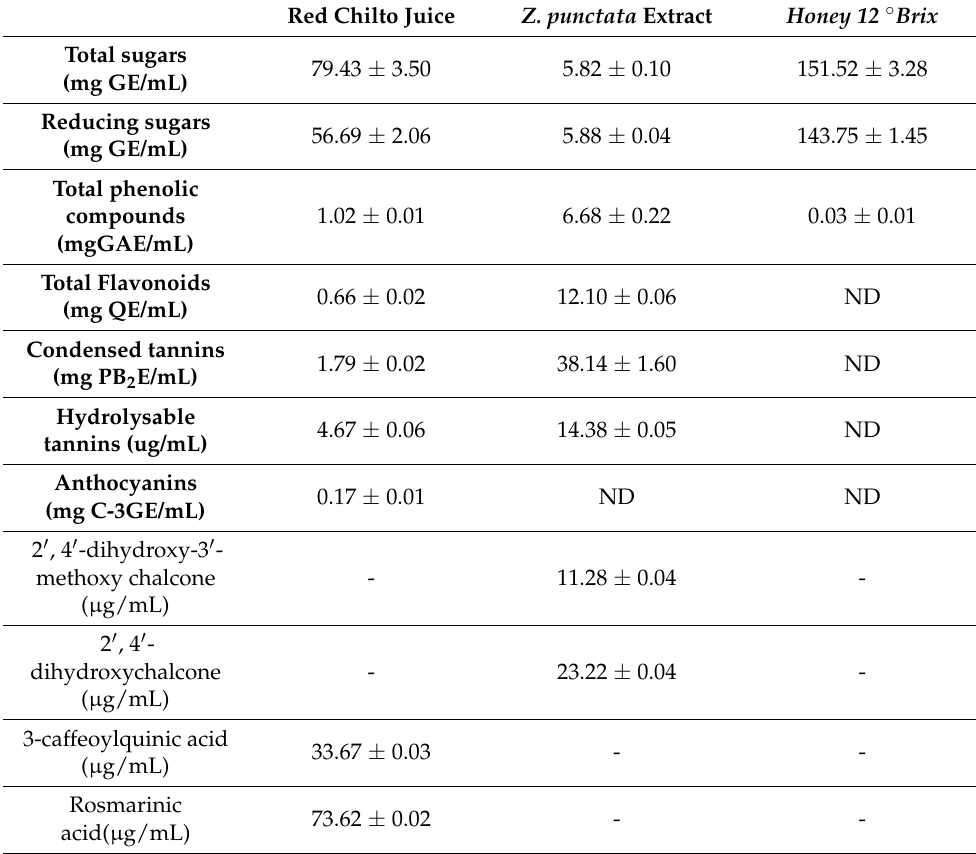
Table 1. Chemical characterization of chilto fresh juice, jarilla extract and